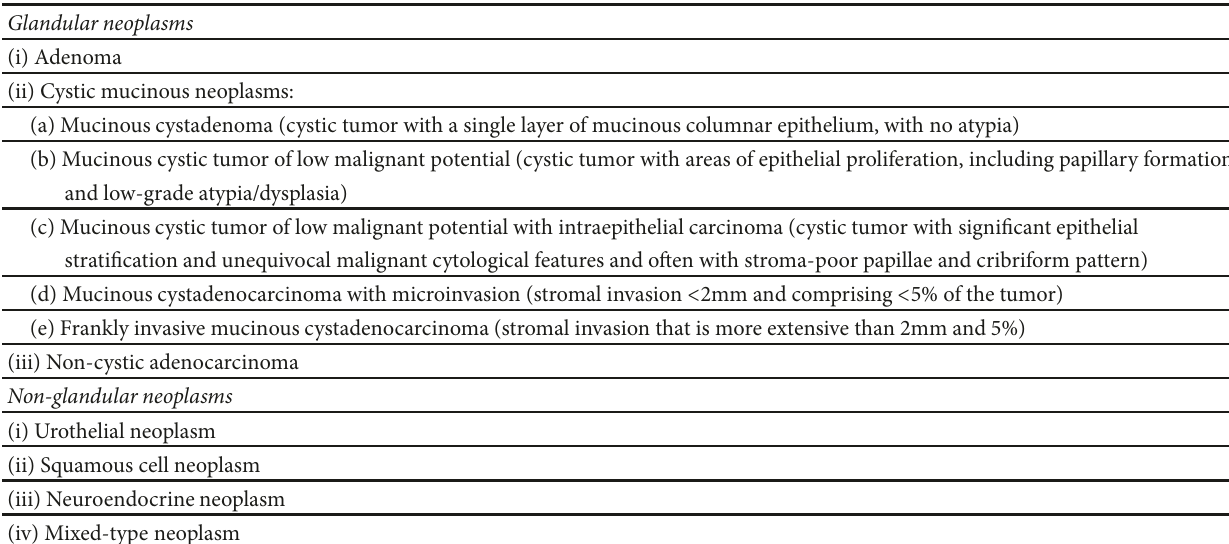
Table 1: Classification of epithelial neoplasms of urachal origin with emphasis on the cystic mucinous neoplasms, modified from Paner et al., 2016, & Amin et al., 2014 [10, 12].